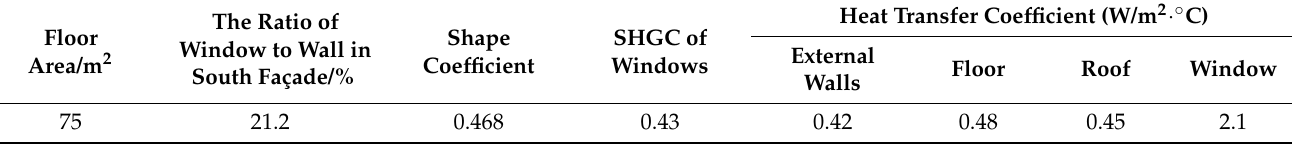
Table 3. Building envelope construction. Figure 2. A photo of the full-scale experimental house ( a ) in winter ( b ) in summer. Table 2. Building information.